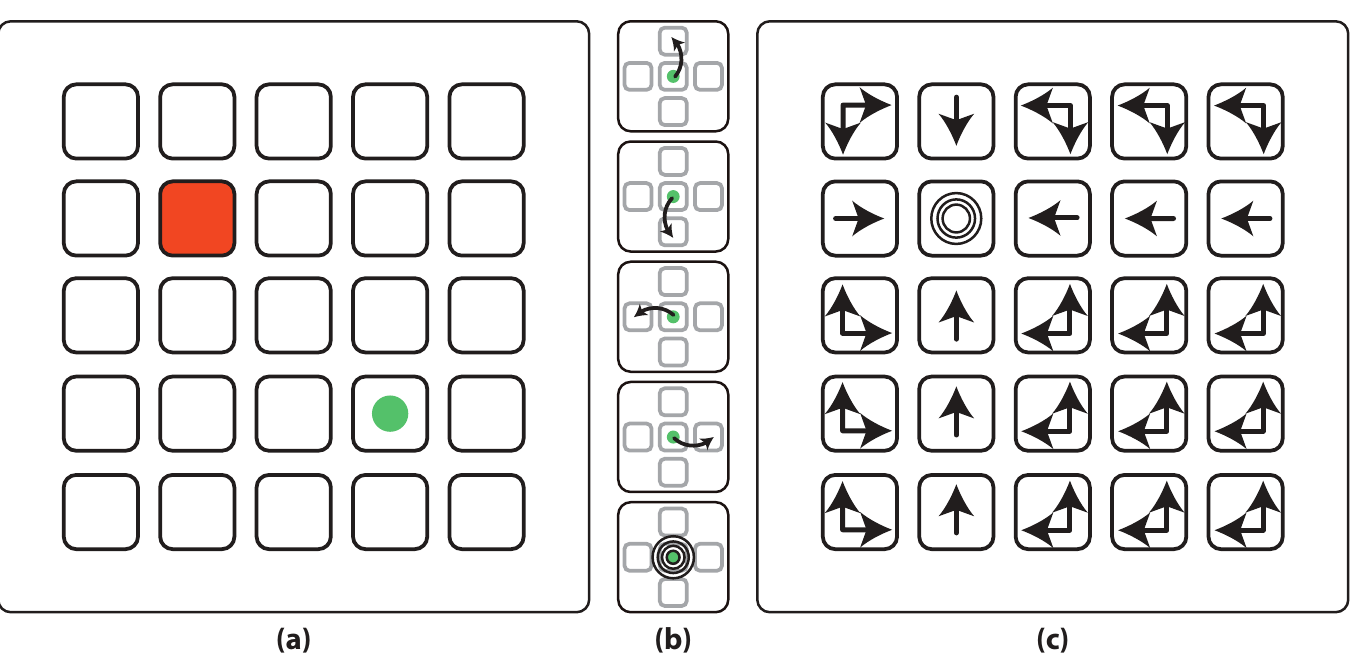
Fig 1. Experimental protocol. (a) Experimental protocol. The protocol showed a 5 × 5 grid with a virtual cursor (green circle) and a goal location (shadowed in red). (b) The cursor could perform five different actions (from top to bottom, move one position up, down, left, right, or performing a goal-reached action). (c) Correct actions (i.e. optimal policy) from each state for the goal exemplified in (a). Extracted from [18] with